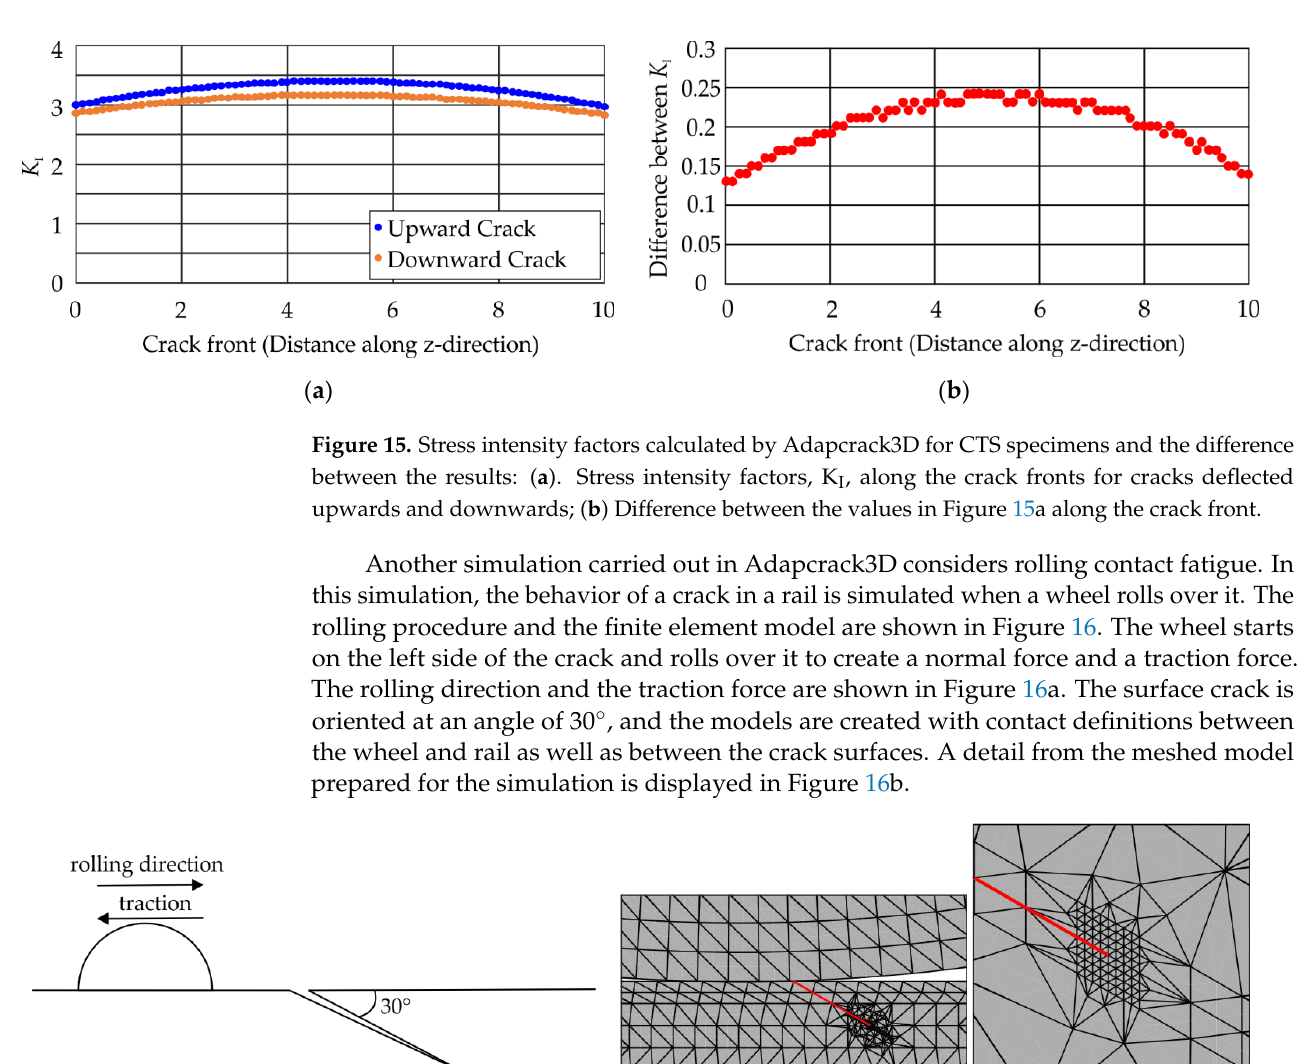
( b ) Figure 14. Maximum principal stresses in global models of CTS specimen with deflected cracks: ( a ). Crack with upward deflection of 60° and Mode I loading along the crack surfaces; ( b ) Crack with downward deflection of 70° and Mode I and Mode II loadings along the crack surfaces. The stress intensity factors at the crack tip calculated from both models are shown in Figure 15. Figure 15a displays the stress intensity factors K I along the crack front for both